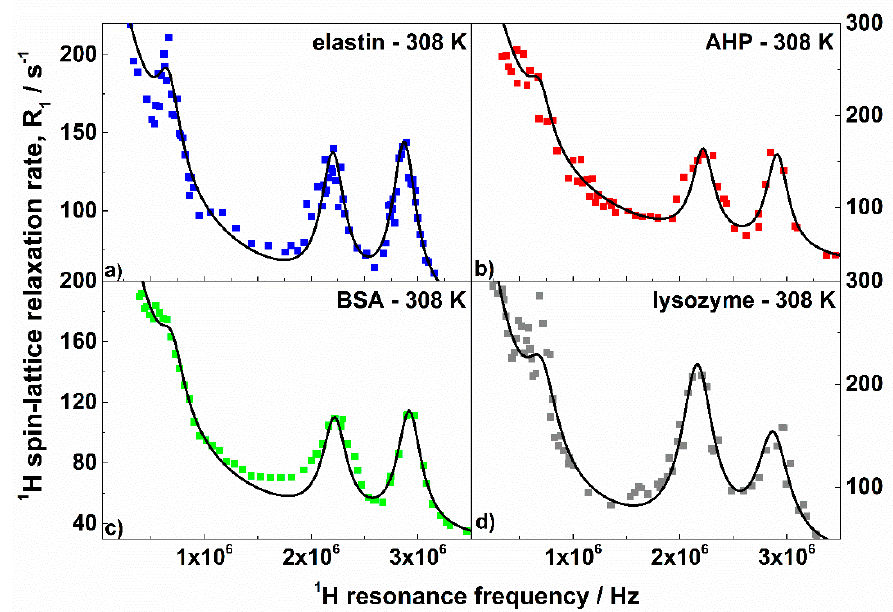
Figure 4. 1 H spin–lattice relaxation rates, R HH , for: ( a ) elastin, ( b ) AHP, ( c ) BSA, and ( d ) lysozyme in the solid state at 308 K in the frequency ranges in which the quadrupole peaks are present. The black lines are theoretical fits.